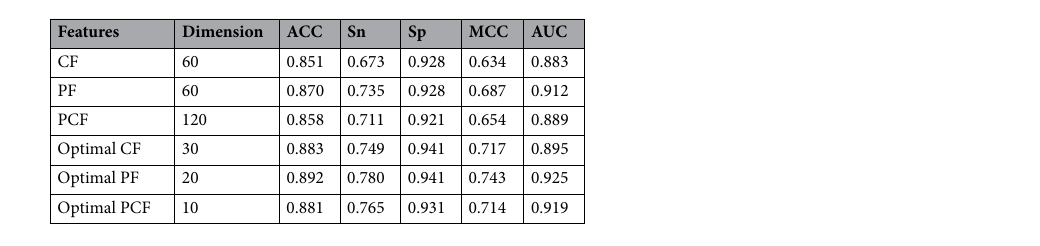
Table 2. Cross-validation results for different feature representations using class and probabilistic information.